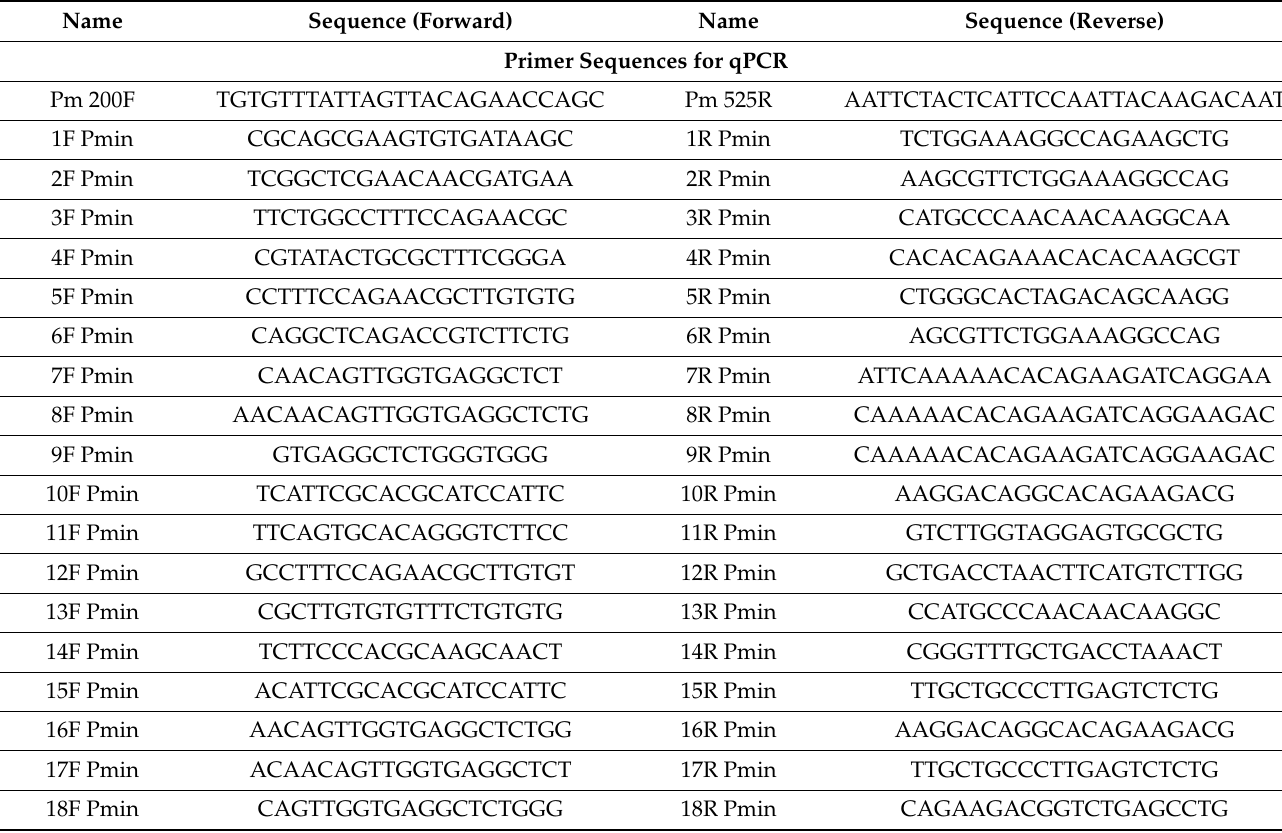
Table 1. Names and sequences of all the primers used in this project. Primers 200F and 525R are taken from [51]. The other primers were designed using the online Primer-BLAST software (NCBI). All reverse primers are in reverse complement.